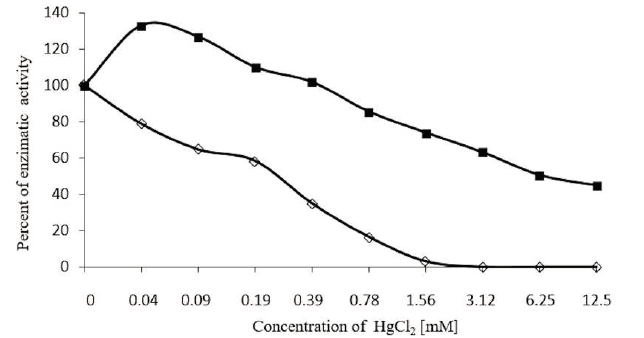
Figure 9. Effect of 2-mercaptoethanol on β -glucosidase , inhibited previously using HgCl 2 at different concentrations (0.04 to 12.5 mM ◊─◊ ) at 35 °C, 30 min, enzymatic activity was determined using p -nitrophenyl- β -glycopyranoside, and after incubating with 50 µL of 2-ME 100 mM ■─■ under the same conditions. Enzymatic activity was recorded at 410